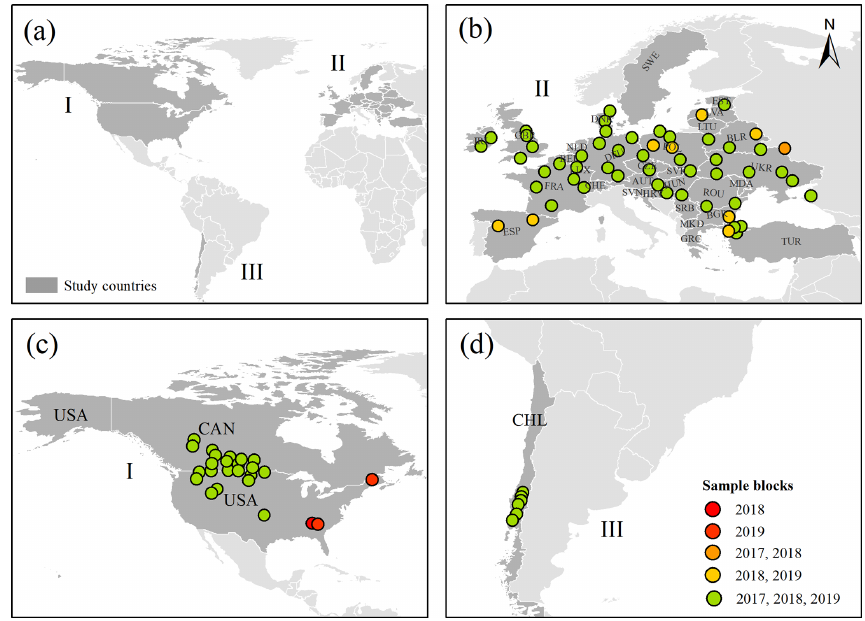
Figure 1. Locations of 10km radius sample blocks for phenological monitoring in the 33 countries in this study. The 33 countries include Canada (CAN), United States of America (USA), Chile (CHL), Ireland (IRL), United Kingdom of Great Britain and Northern Ireland (GBR), France (FRA), Spain (ESP), Netherlands (NLD), Belgium (BEL), Luxembourg (LUX), Germany (DEU), Switzerland (CHE), Denmark (DNK), Sweden (SWE), Poland (POL), Czechia (CZE), Austria (AUT), Slovenia (SVN), Croatia (HRV), Slovakia (SVK), Hungary (HUN), Estonia (EST), Latvia (LVA), Lithuania (LTU), Belarus (BLR), Ukraine (UKR), Republic of Moldova (MDA), Romania (ROU), Bulgaria (BGR), Serbia (SRB), North Macedonia (MKD), Greece (GRC), and Turkey (TUR). Country names and codes are the same as those used by the Statistics Division of the United Nations Secretariat. The three-digit alphabetical codes assigned by the International Organization for Standardization can be found at https://unstats.un.org/unsd/methodology/m49/ (last access: 8 June